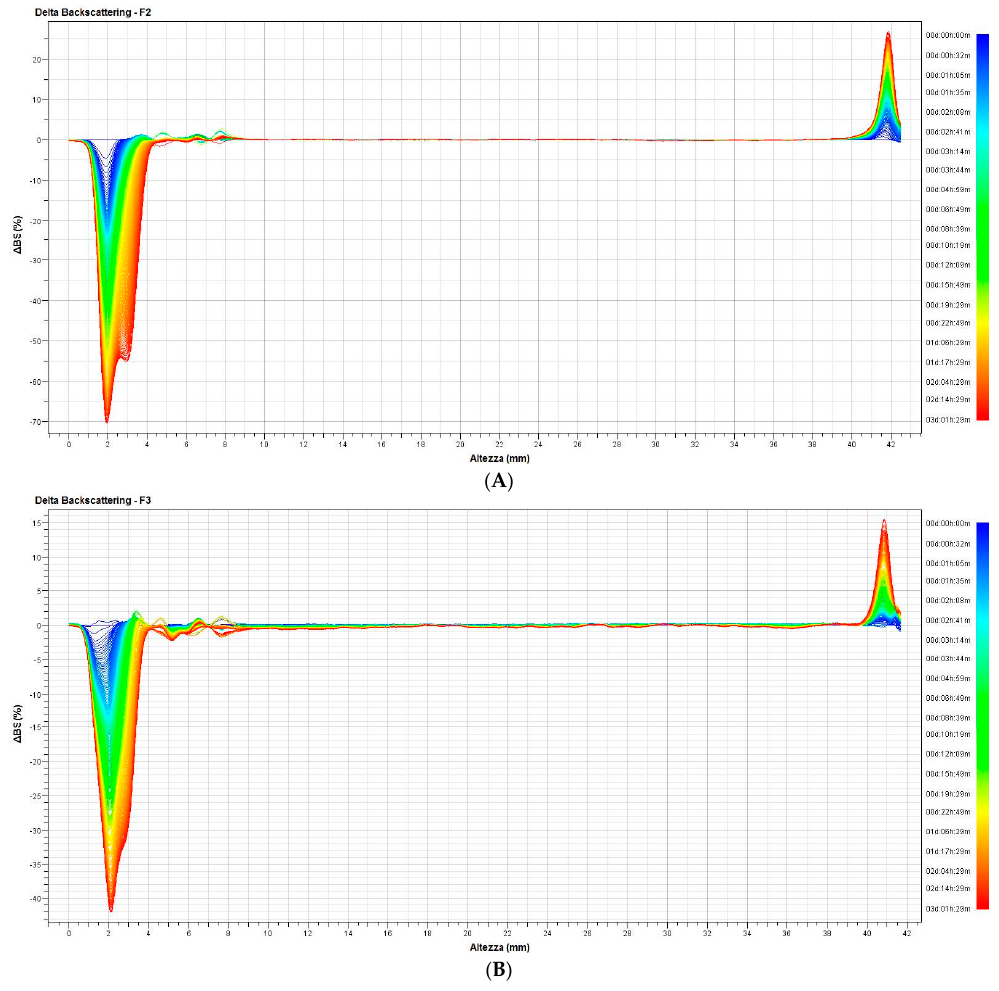
Figure 9. Δ BS (%) of ( A ) F2 and ( B ) F3 samples. Figure 9. ∆ BS (%) of ( A ) F2 and ( B ) F3